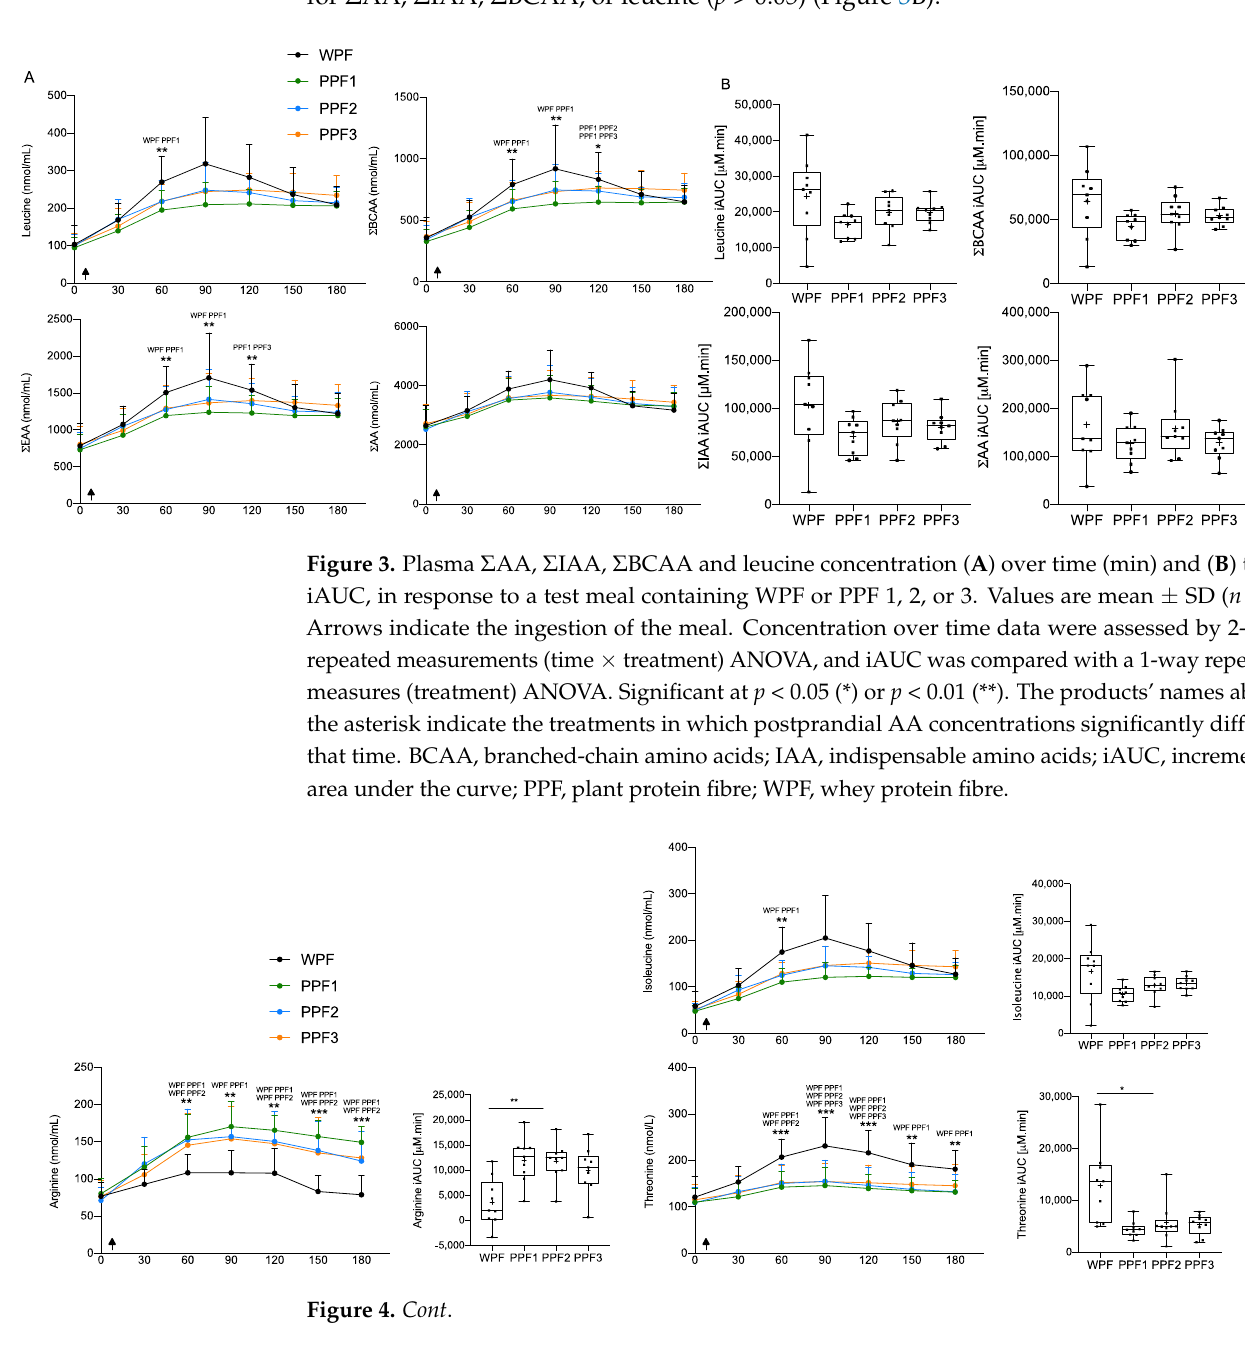
Figure 4. Single AA plasma concentrations, over time (min) and their iAUC, showed a significantly different response post WPF than PPF 1, 2, or 3 meals. Values are mean ± SD (n = 9). Arrows indicate the ingestion of the meal. Concentration over time data were assessed by 2-way repeated measure- ments (time x treatment) ANOVA, and iAUC was compared with a 1-way repeated measures (treat- ment) ANOVA. Significant at p < 0.05 (*), p < 0.01 (**) or p < 0.001 (***). The products’ names above asterisk indicate the treatments in which postprandial AA concentrations significantly differ at that time point. BCAA, branched-chain amino acids; IAA, indispensable amino acids; iAUC, incremental area under the curve; PPF, plant protein fibre; WPF, whey protein fibre. 3.3. Other Amino Acids Arginine, tyrosine, and phenylalanine displayed lower postprandial availability fol- lowing WPF ingestion than PPF products (Figure 4). While arginine’s postprandial con- centration curve was significantly lower at all time points after 30 min, tyrosine and phe- nylalanine postprandial concentration curves had similar C max for all test meals. Yet, after PPF, these concentrations were more sustained, creating a significant difference at the lat- est time points (150 and 180 min). All three AA were present at higher concentrations in the PPF- vs. the WPF-containing meal (Table 2), which could explain (part of) the observed differences, especially for arginine. In contrast, postprandial plasma threonine and cysteine concentrations were higher after WPF vs. PPF products consumption (Figure 4). Again, this probably reflects their higher concentration in the WPF-containing meal (Table 2), although it seems that differ- ent protein metabolism is occurring with AA from the PPF products. Surprisingly, alt- hough methionine was present at higher concentrations in the PPF products, postprandial